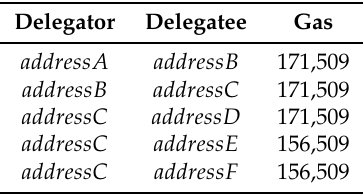
Table 7. Gas Used in BlendCAC’s delegation()